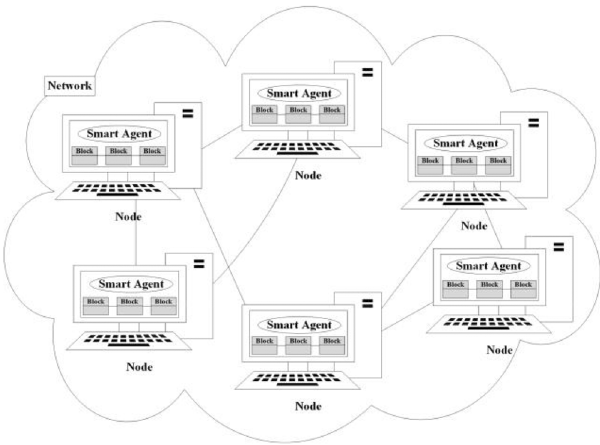
Figure 2. Network topology of a smart agent